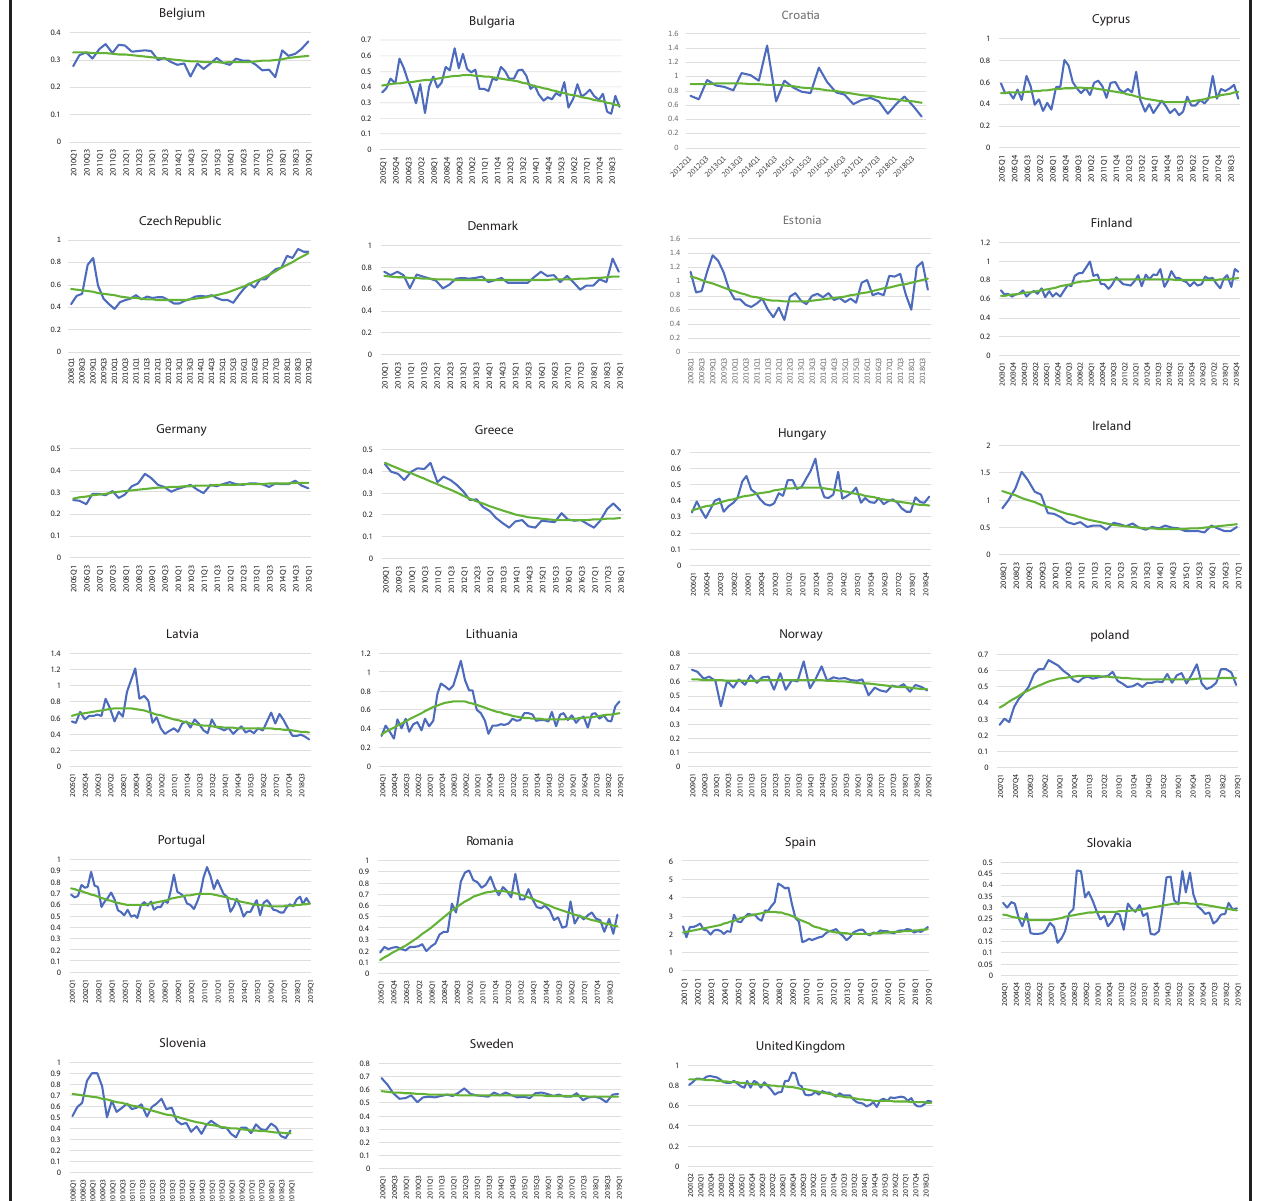
Figure A1 Evolution of matching efficiency in